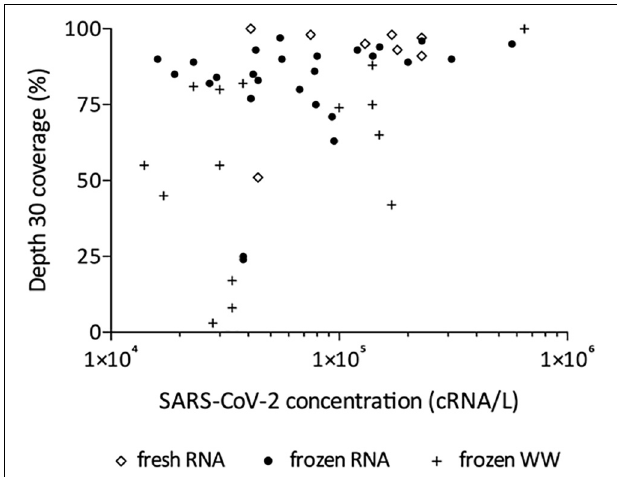
FIGURE 3 | Effect of SARS-CoV-2 concentration on depth 30 genome coverage using the adapted method and starting from freshly prepared RNA, frozen RNA and frozen wastewater (WW). Spearman test was used to test correlation between the two parameters for all samples ( p = 0.0004, r = 0.4881) and each group individually: frozen RNA samples ( p = 0.0349, r = 0.4153), fresh RNA samples ( r = 0.3253, p > 0.05), and frozen WW samples ( r = 0.3522, p >